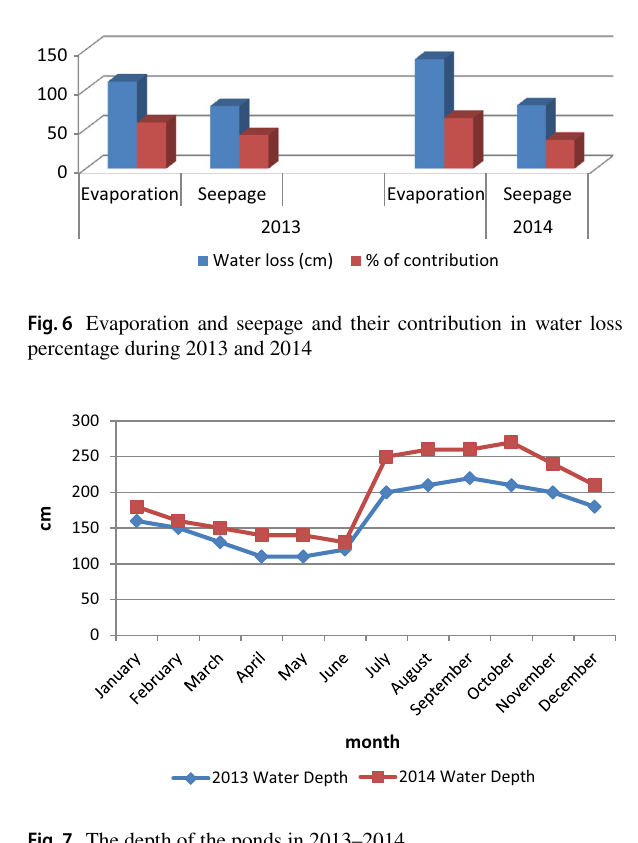
Fig. 7 The depth of the ponds in